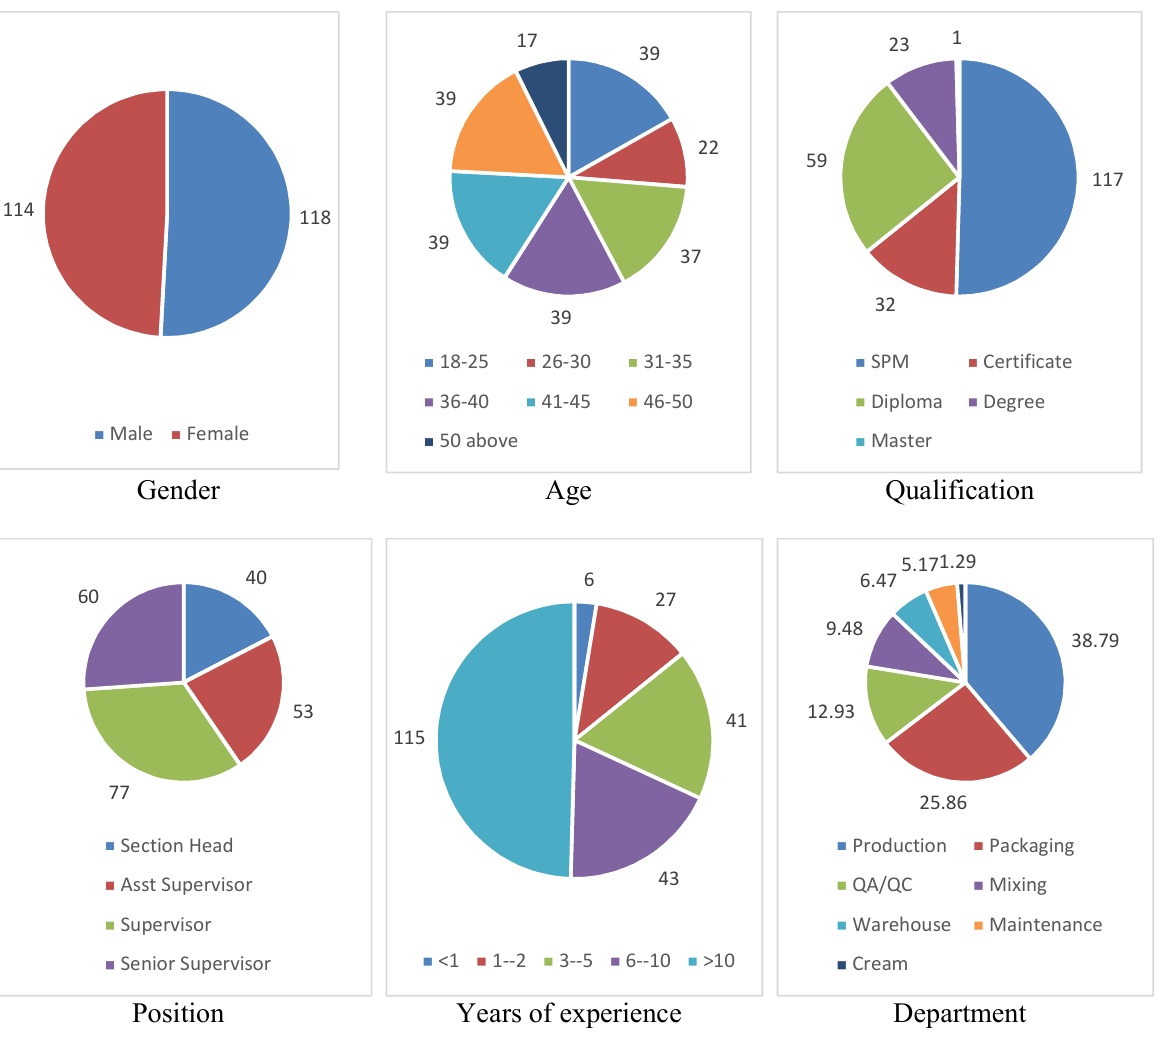
Fig. 2. Personal characteristics of the people participated in the